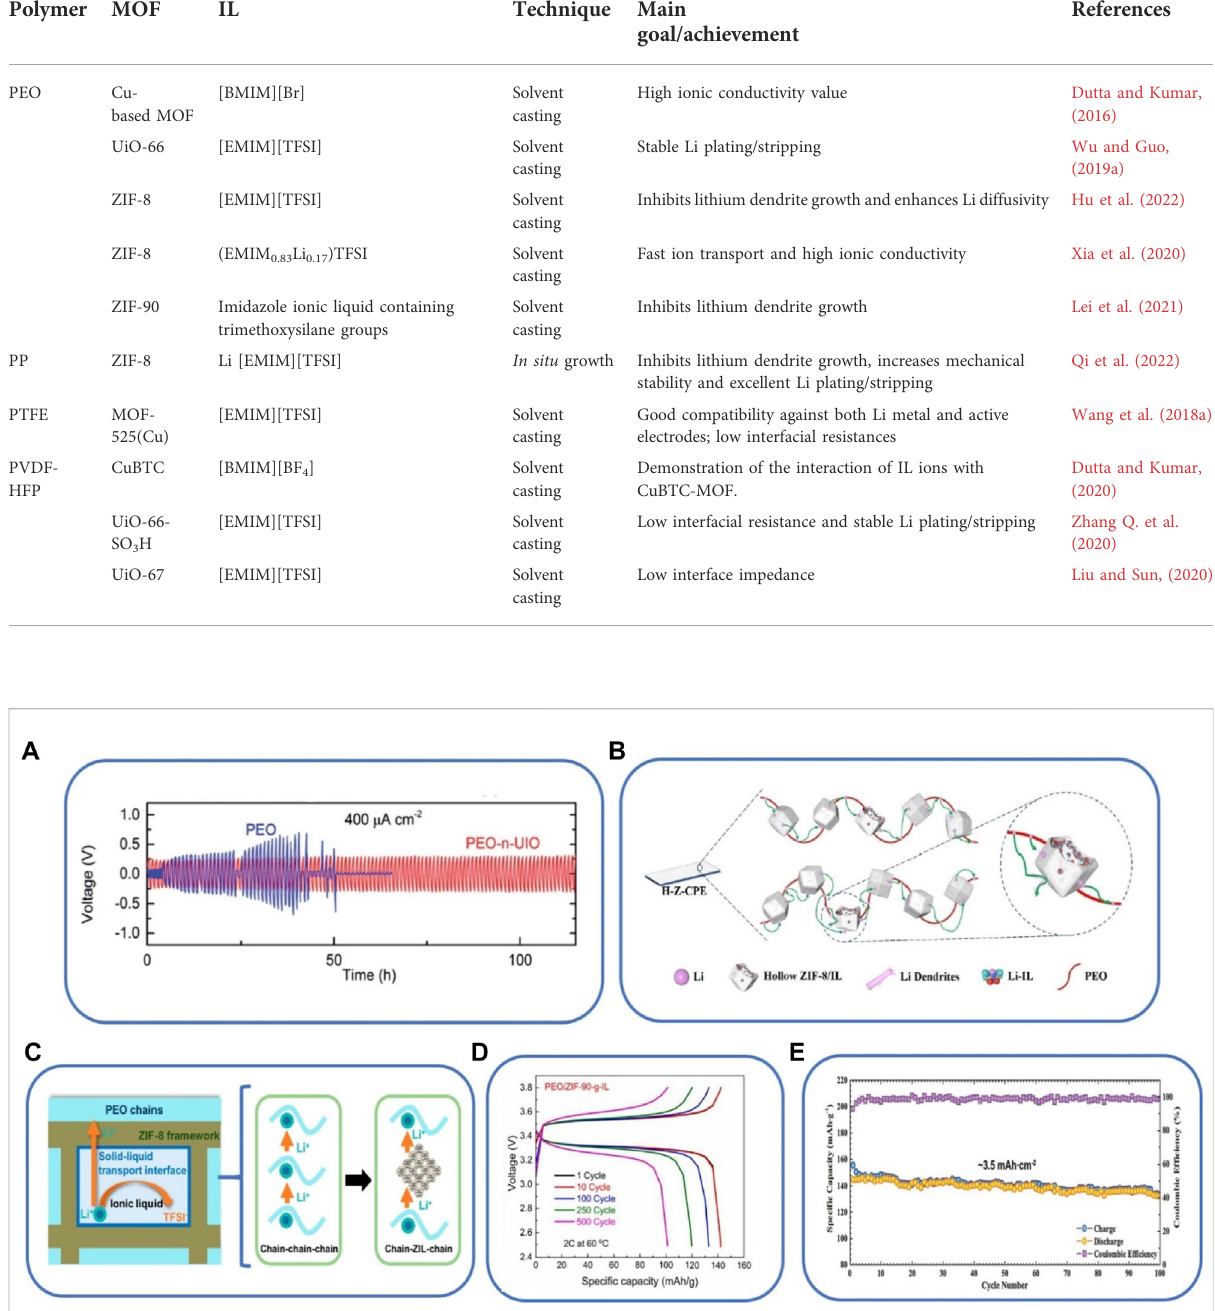
TABLE 2 State of the art of the use of IL@MOF for the development of solid polymer electrolytes in lithium-based batteries. Polymer MOF